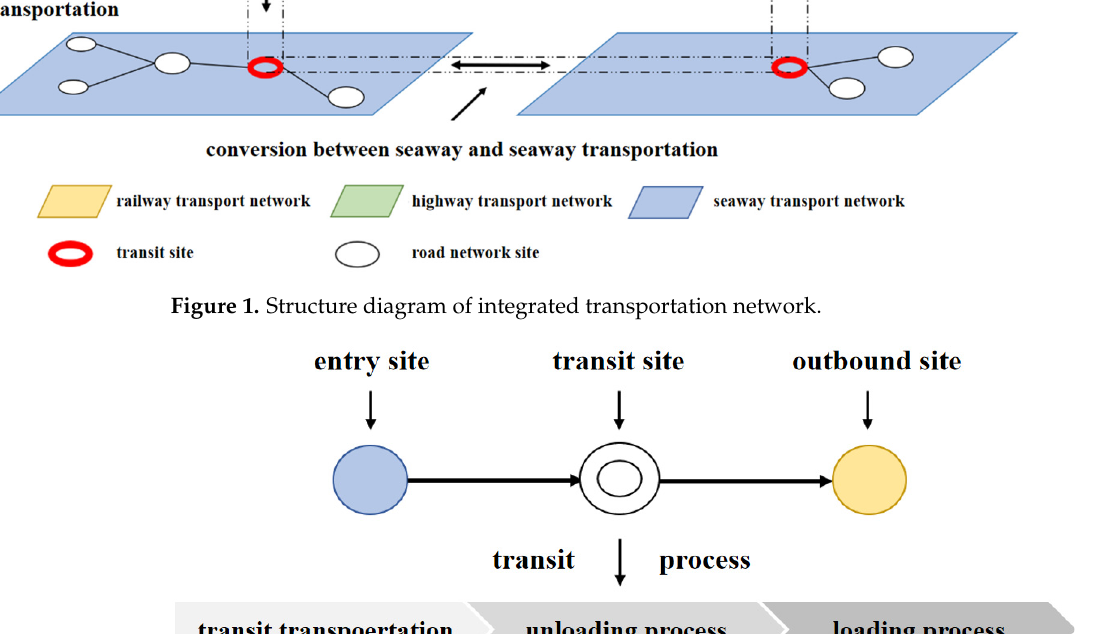
Figure 1. Structure diagram of integrated transportation network.